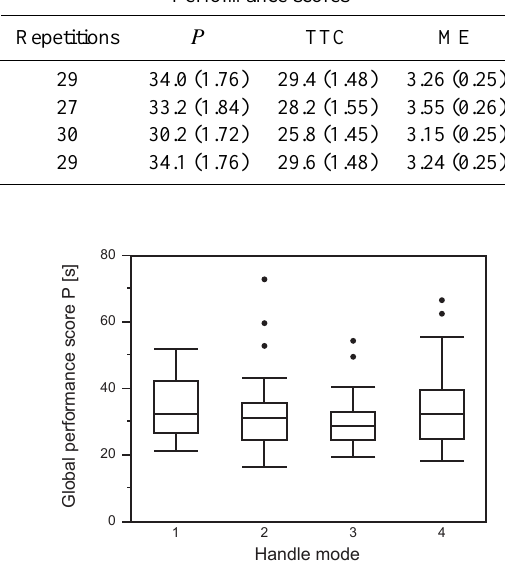
Figure 5. Box-and-whisker plot of the average RULA-based score for each handle mode. Sample size for each box is reported in Ta- ble 1. Outliers are represented as dots.